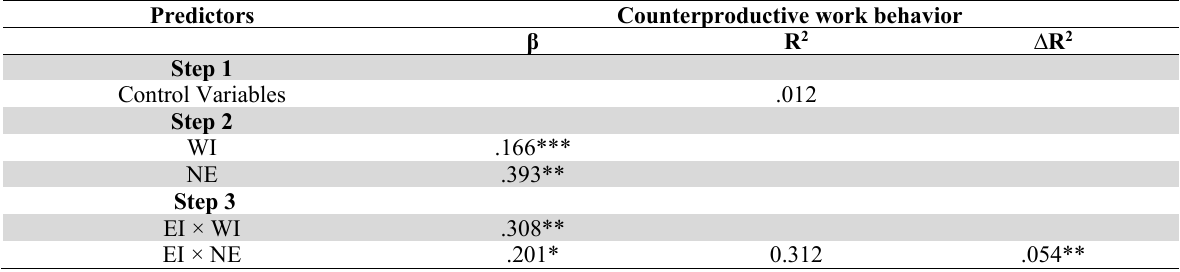
Multiple Regression Analysis